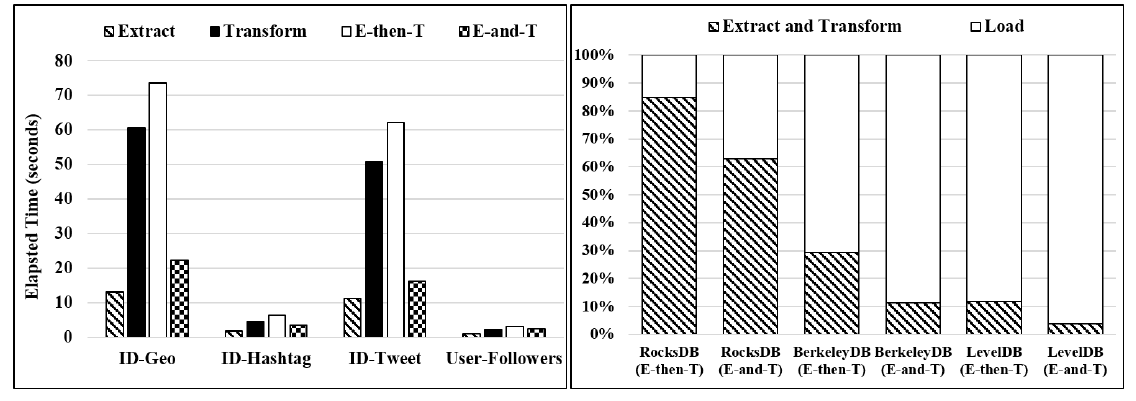
( a ) Performance of E-then-T and E-and-T. ( b ) Portion of E-then-T and E-and-T. Figure 16. The performance analysis of the proposed ETL methods for WR-Store.